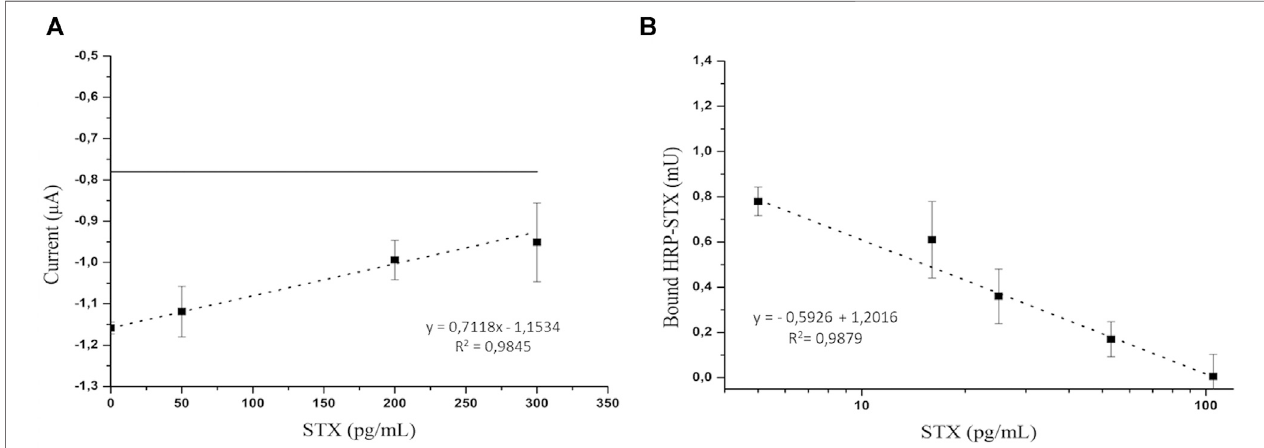
FIGURE 5 | (A) Electrochemical detection of the competitive assay using a STX concentration in the range from 0 to 300 pg/ml. The horizontal line indicates the electrochemical background signal; (B) optical detection of the competitive assay using an STX concentration in the range from 0 to 100 pg/ml.